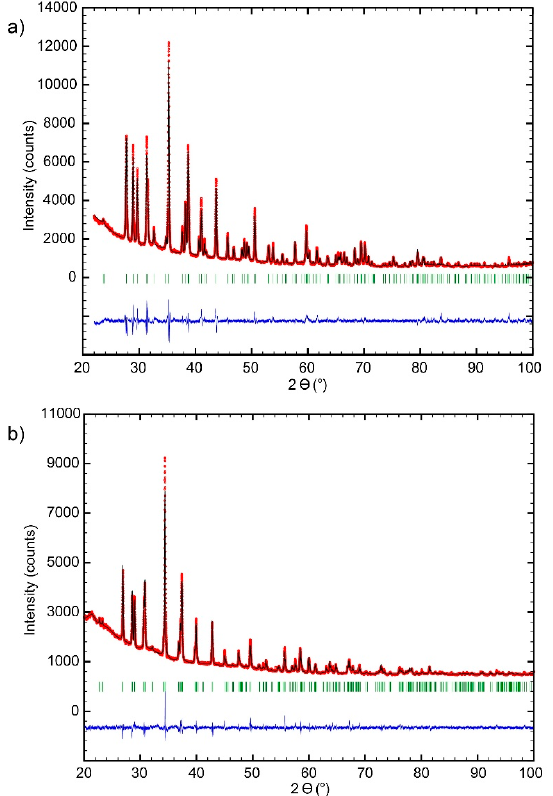
Figure 4. Rietveld refinement of the X-ray powder pattern of Zn 2 NCl 0.47 Br 0.53 ( a ) and Zn 2 NBr 0.62 I 0.38 ( b ) showing measured and fitted intensities ( red/black) , the position of the Bragg peaks ( green ) and the difference curve ( blue ).